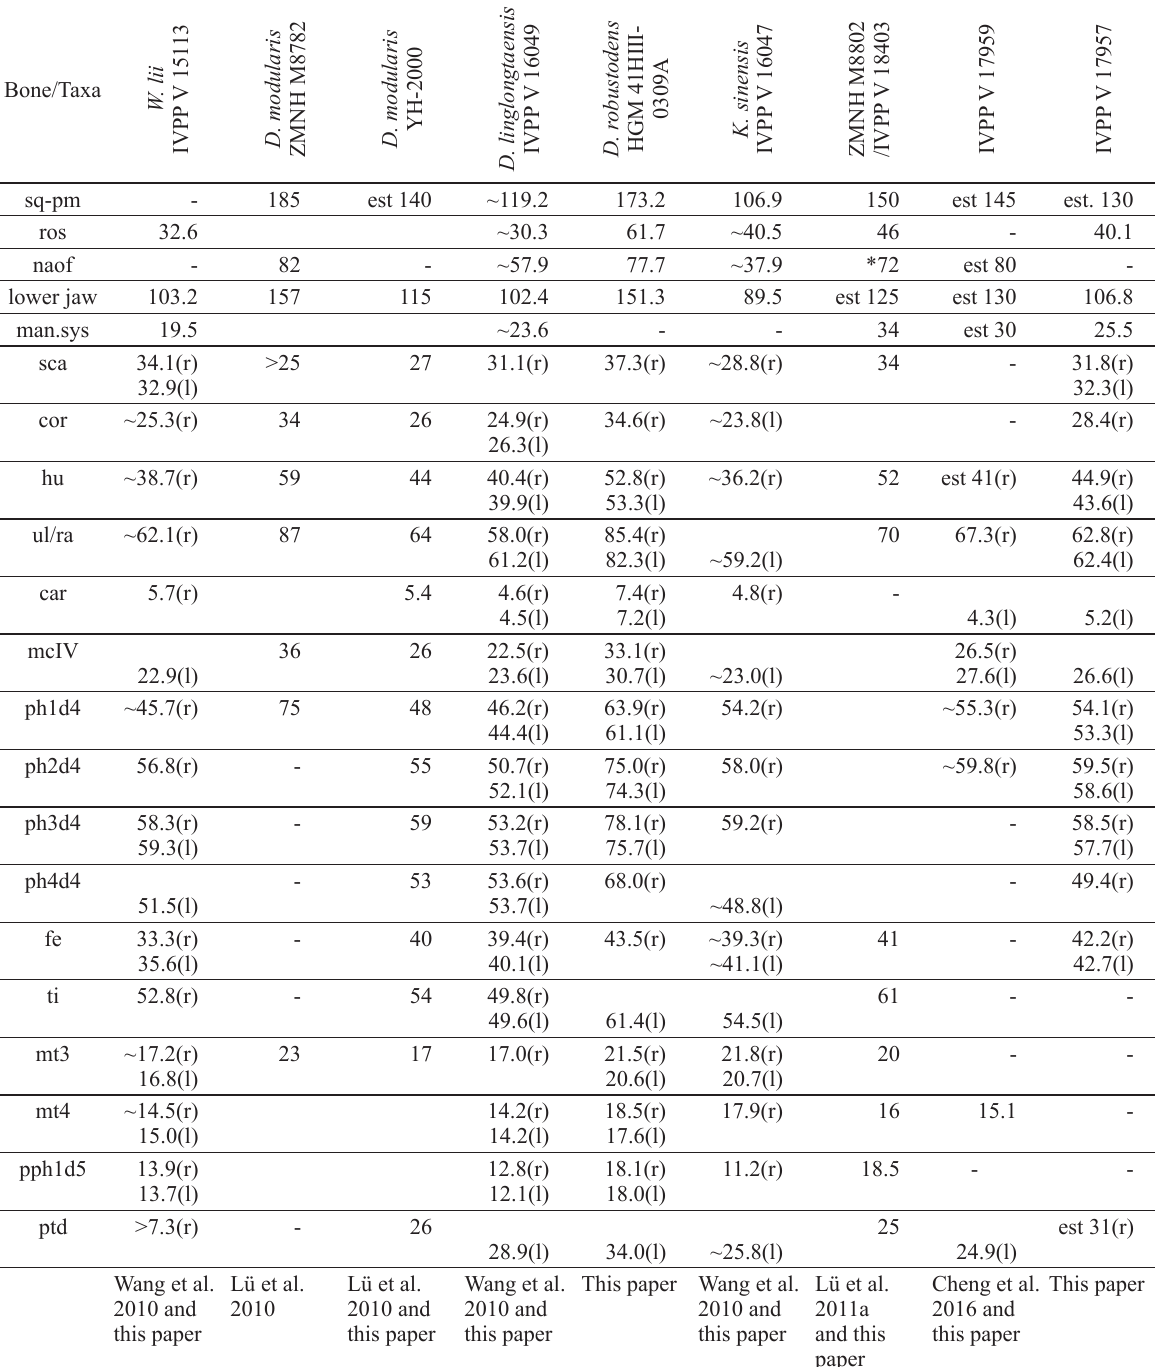
Measurements of IVPP V 17957 and other published wukongopterid specimens (in